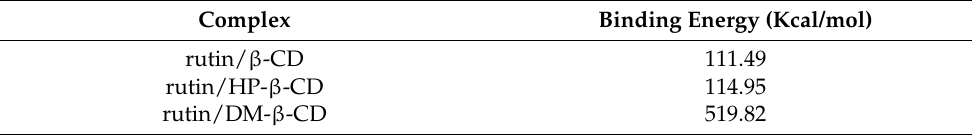
Table 4. Binding energies of the three cyclodextrin–rutin inclusions.